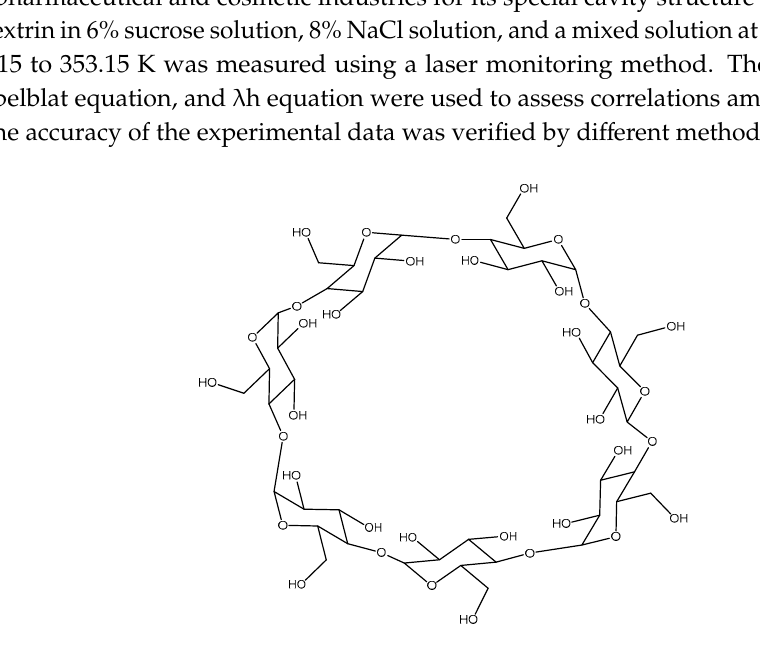
Figure 1. Chemical structure of β -Cyclodextrin.